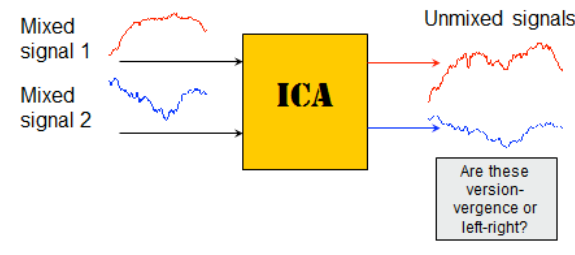
Figure 4 General structure of independent components analysis. Combinations of signals (left side) are um-mixed by the ICA algorithm to recover the original source signals (right